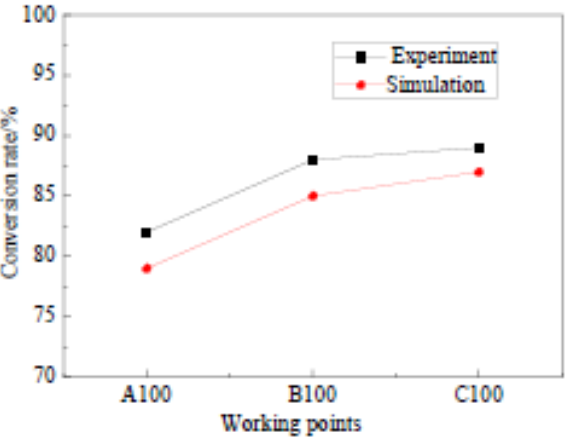
Fig. 4 Comparison of catalytic conversion rate between calculation and test.